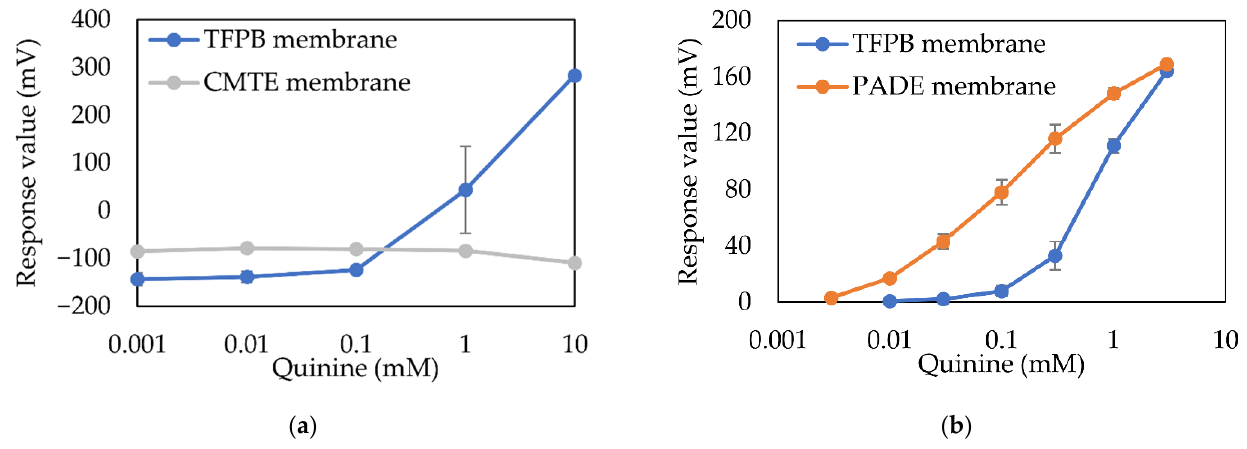
Figure 12. The examples using TFPB membranes and other membranes to measure bitterness samples: ( a ) TFPB (30 mM) membrane and CMTE membrane; ( b ) TFPB (15 mM) membrane and PADE (35 mM) membrane, respectively.